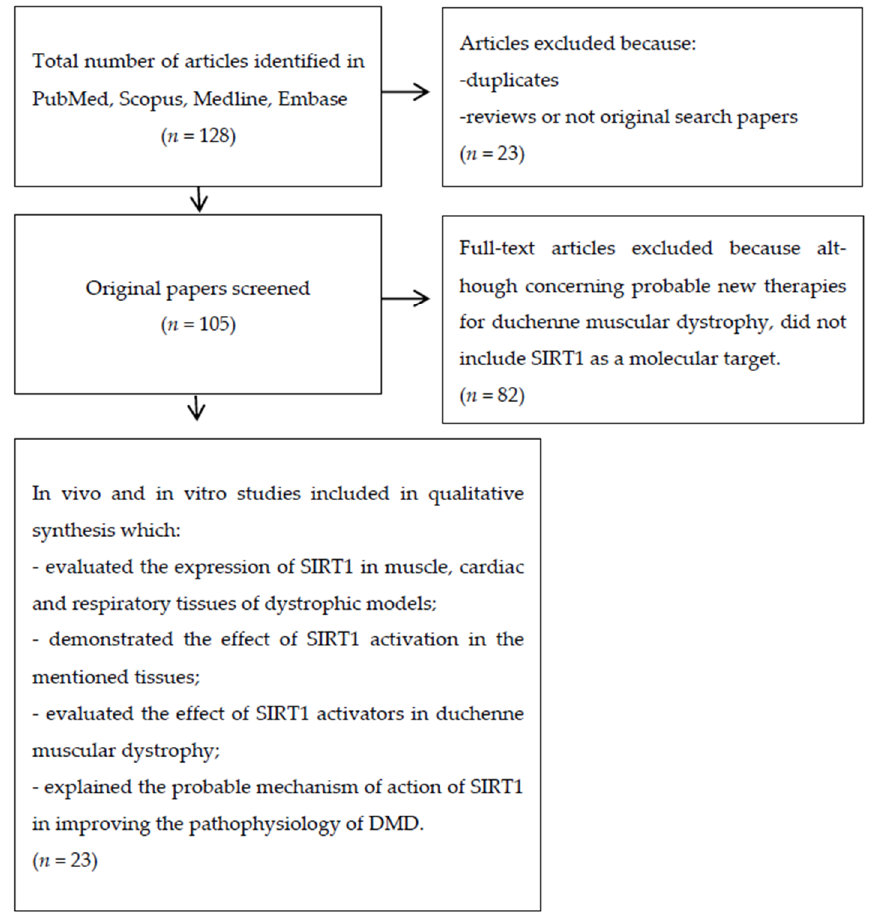
Figure 2. Prisma flow diagram represents the steps we followed during the literature search and article selection for this systematic review.